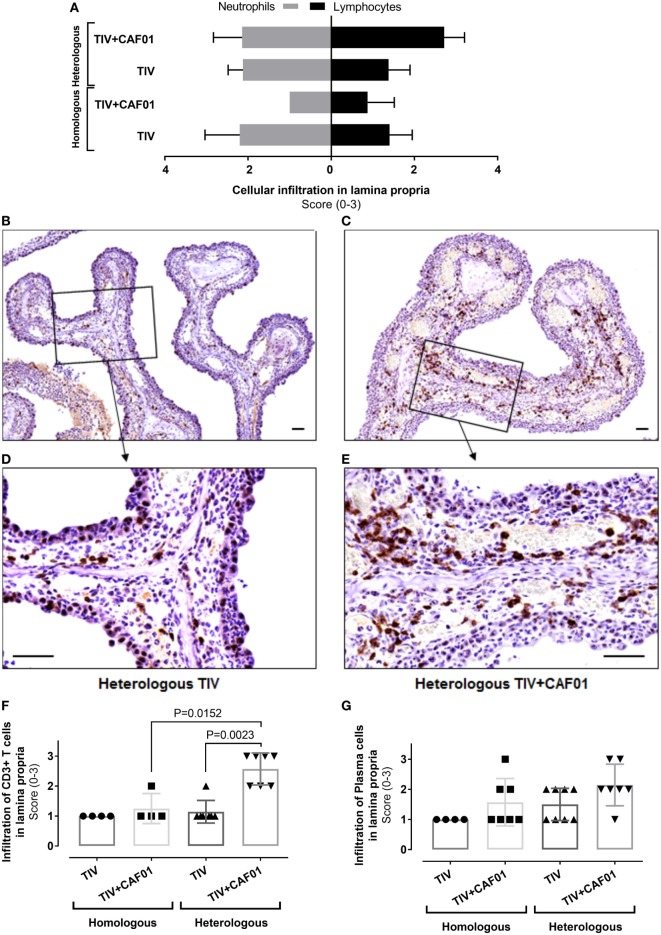
Composition of cellular infiltration to the site of infection is influenced by CAF01 adjuvantation. Ferrets immunized two times with either the homologous or heterologous trivalent influenza split-virion (TIV) vaccine with or without CAF01 adjuvant and euthanized 4 days after challenge with A/Brisbane/59/2007. (A) Score of number of infiltrating neutrophils’ (gray bars) and lymphocytes (black bars) in lamina propria hematoxylin and eosin (H&E)-stained sections, n = 4 (homologous TIV), 6 (homologous + CAF01), and 8 (heterologous TIV ± CAF01). Bars show mean value + SD. (B–E) Representative histological sections with immunohistochemical detection of CD3 showing brown colored CD3(+) T cells in heterologous TIV (B,D) and heterologous TIV + CAF01 (C,E). Bars = 50 μm. (F) Score of number CD3(+) T cells and (G) plasma cells (H&E-stained section) in lamina propria. Dots represent individual values and lines median values. Statistical analysis: the Mann–Whitney two-tailed U test was applied to compare infiltration of cells between groups. Statistical significant difference is shown by p-value.